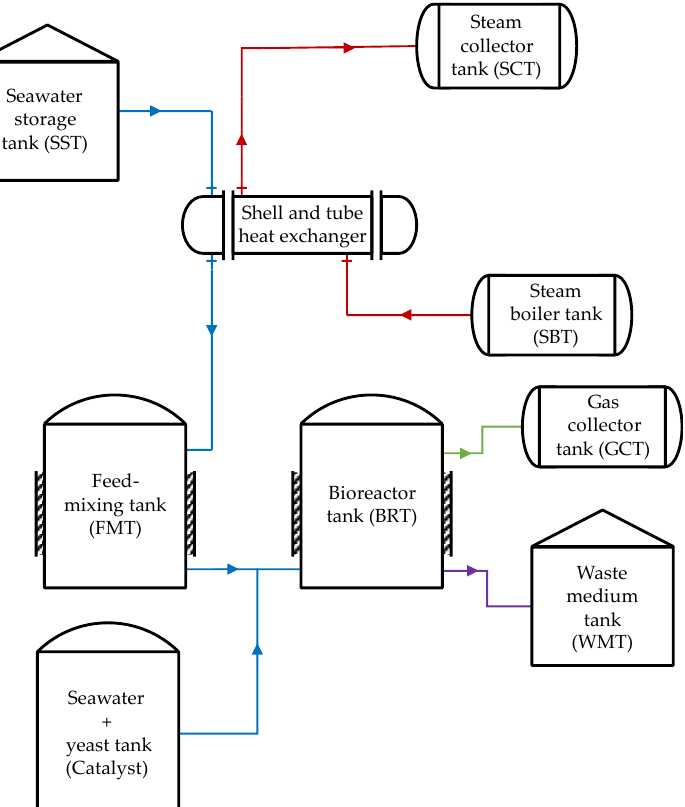
Figure 3. Schematic drawing of the lab-scale biohydrogen production system.